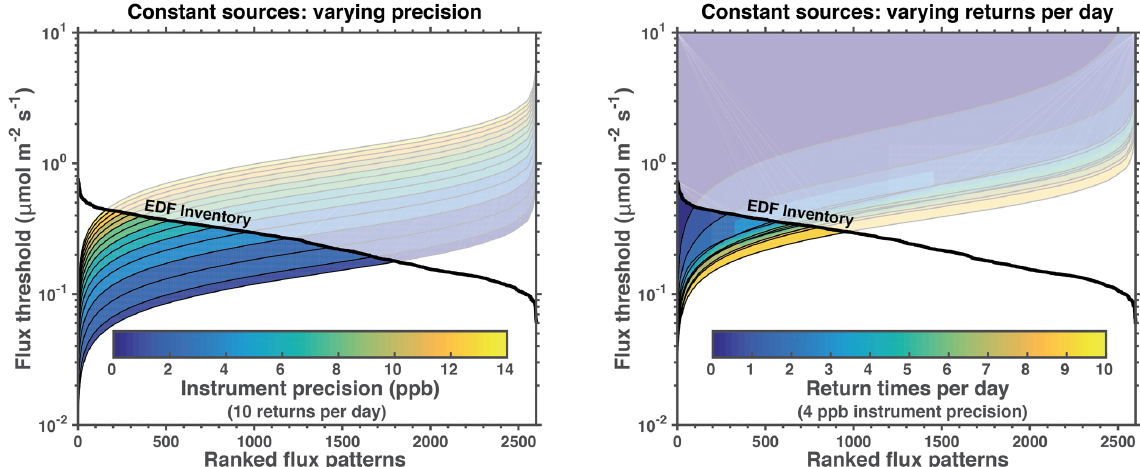
Figure 6. Capability of GeoCARB-like satellite configurations to resolve the fine-scale (1.3 × 1.3km 2 ) patterns of variability of temporally invariant emissions in a 290 × 235km 2 domain and for a 1-week observation period. Left panel shows the results for a configuration with 10 returns per day (hourly observations) where the instrument precision is varied from 0 to 14ppb. Right panel shows the results for a configuration with 4ppb instrument precision and the return frequency per day is varied from 1 to 10. Solid black line shows eigenvalues of the EDF Barnett Shale methane emission inventory (Lyon et al., 2015). The region above the black line is where the noise is larger than the signal. The change in flux threshold as the sampling frequency increases in right panel is not necessarily monotonic, because some of the cases use different subsets of observation (e.g., daily observations are at 13:00LT while twice daily are at 10 and 14).